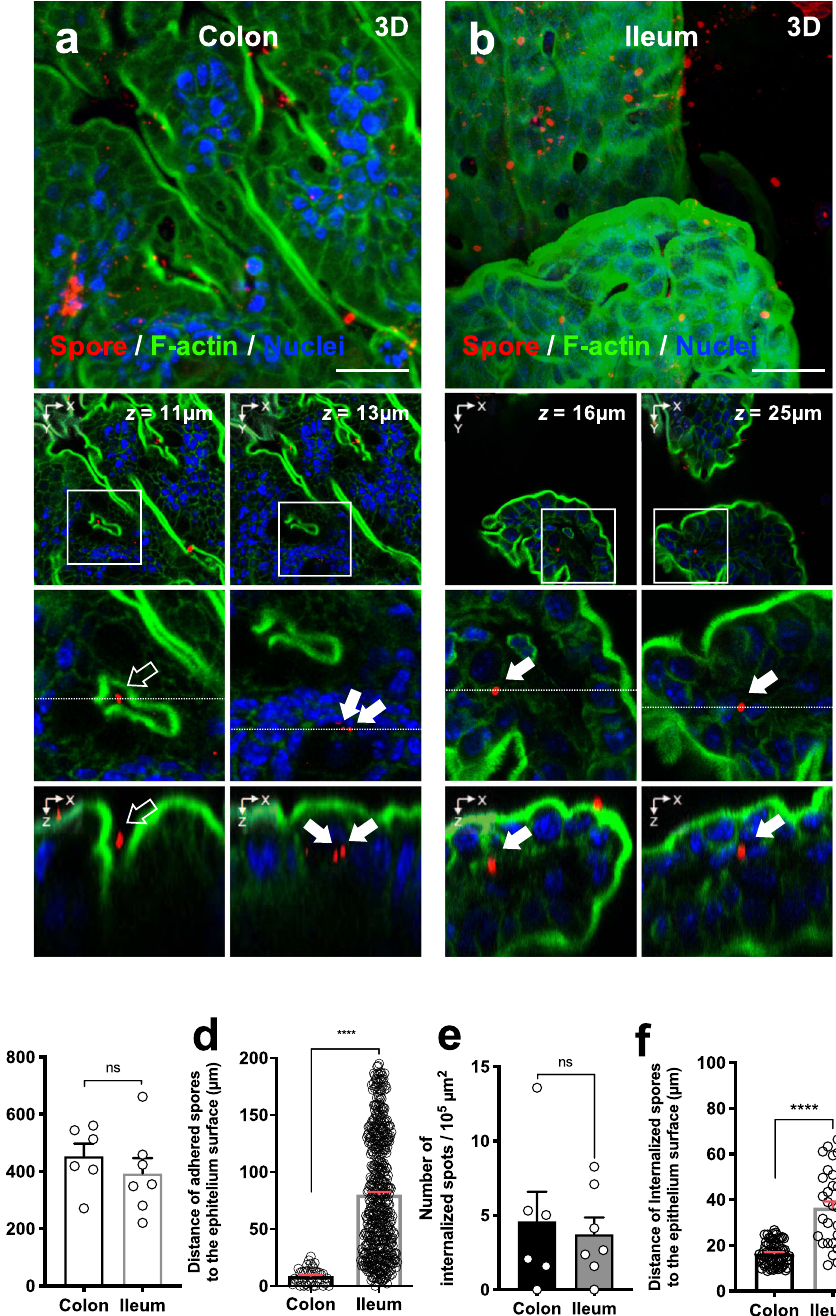
Fig. 1 C. dif fi cile spore adherence and internalization into intestinal barrier in vivo. a , b Representative confocal micrographs of fi xed whole-mount of a colonic, and b ileum mucosa of C57BL/6 mice infected with 5 × 10 8 C. dif fi cile R20291 spores for 5 h. C. dif fi cile spores are shown in red, F-actin is shown in green and nuclei in blue ( fl uorophores colors were digitally reassigned for a better representation). Micrographs are representative of n = 3 independent mice. c Adherence of C. dif fi cile spores to colonic and ileum mice mucosa obtained of four fi elds from n = 6 and n = 7 tissues of independent mice, respectively. d Distance of n = 499 and n = 40 adhered spores from the colonic epithelial apical surface or from the villus tip respectively visualized of two fi elds from n = 2 mice each. e Quanti fi cation of internalized C. dif fi cile spores in the colonic and ileum mucosa obtained of mice described in c . f Distance of internalized spores from the epithelium surface for the colonic mucosa ( n = 71) or from the villus tip to the ileum mucosa ( n = 34) obtained of mice described in c . White arrow and empty arrow denote internalized and adhered C. dif fi cile spores, respectively. Scale bar, 20 µ m. Error bars indicate the mean ± S.E.M. Statistical analysis was performed by two-tailed Mann – Whitney test; ns, p > 0.05; **** p < cells (Supplementary Fig. 7d). Overall, these results demon- species (Fig. 2k). The percentage of internalized spores of 630 strate that C. dif fi cile spores are able to gain intracellular entry and R20291 strains was highest at 5 h post infection in Caco-2 into non-phagocytic cells and that spore entry is serum- and T84 cells (Supplementary Fig. 7b, c). Spores of various dependent in vitro. clinically relevant ribotypes were able to internalize into Caco-2